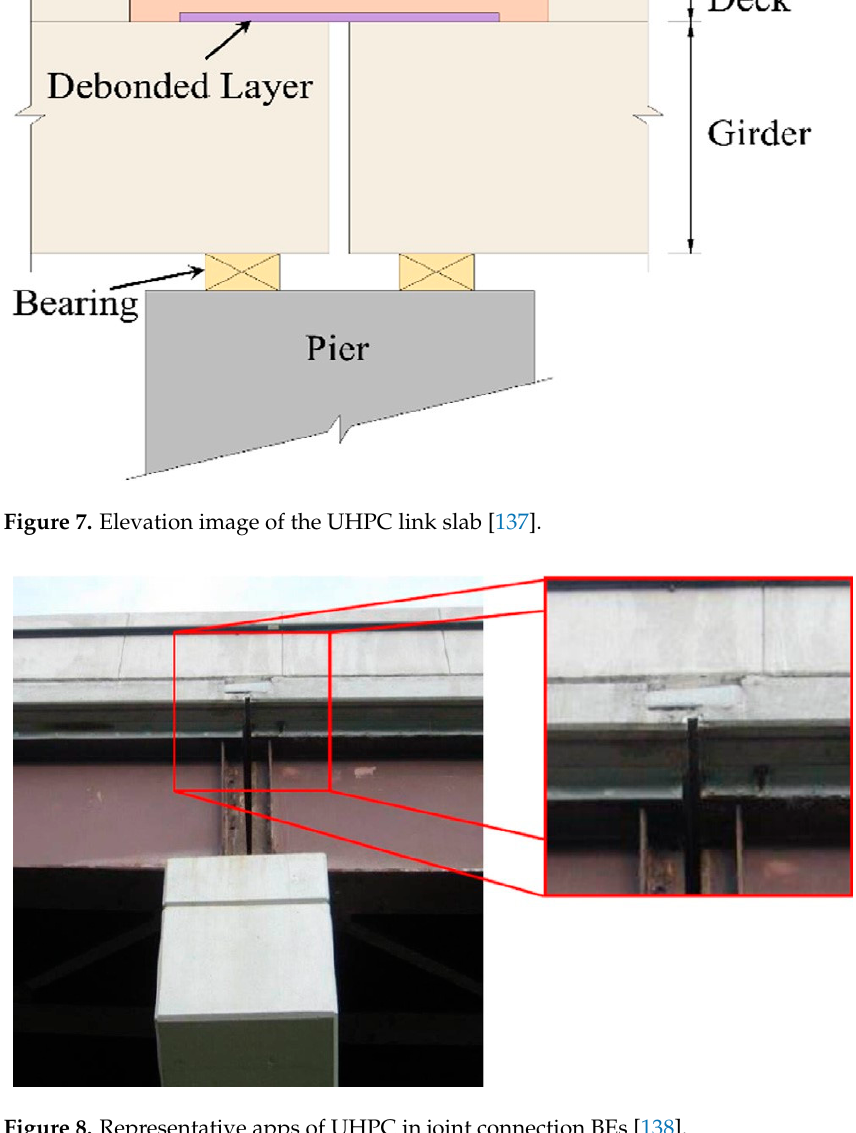
Figure 8. Elevation image of the UHPC link slab [137] . Figure 8. Representative apps of UHPC in joint connection BEs